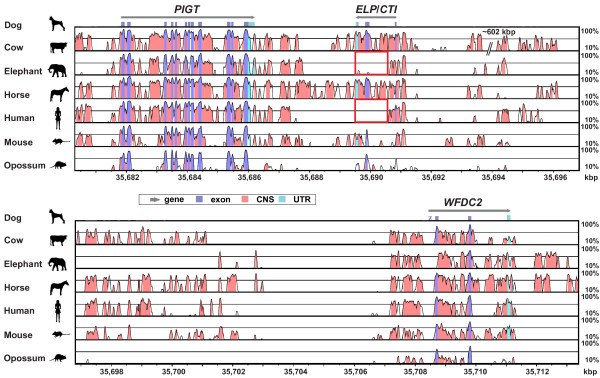
VISTA plot of pairwise alignments for selected mammals in the region containing thePIGT,ELP/CTIandWFDC2genes. Sequence homology within the PIGT-ELP/CTI-WFDC2 region of the dog, cow, elephant, horse, human, mouse and opossum genomes was determined with mVISTA [64]. The dog sequence was used as the reference sequence (horizontal axis, dog chromosome 24 numbering). Grey horizontal arrows indicate gene location and direction of transcription. Blue rectangles indicate coding exons and untranslated regions (UTRs) of the gene are depicted by light green rectangles. Exon 1 of canine WFDC2 was missing (gap in the current assembly) from the dog genome and is indicated by a blue rectangle with diagonal white stripes. The right axis indicates the percentage identity within a 100 bp window for each pairwise comparison, ranging from 10% to 100%. Regions sharing greater than 25% identity are shaded and the black horizontal line indicates 70% identity. The region containing the Kunitz domain-encoding ELP/CTI exon 2 was conserved in the cow, horse, mouse and opossum, but was absent in the elephant and human CTI genes (red boxes).